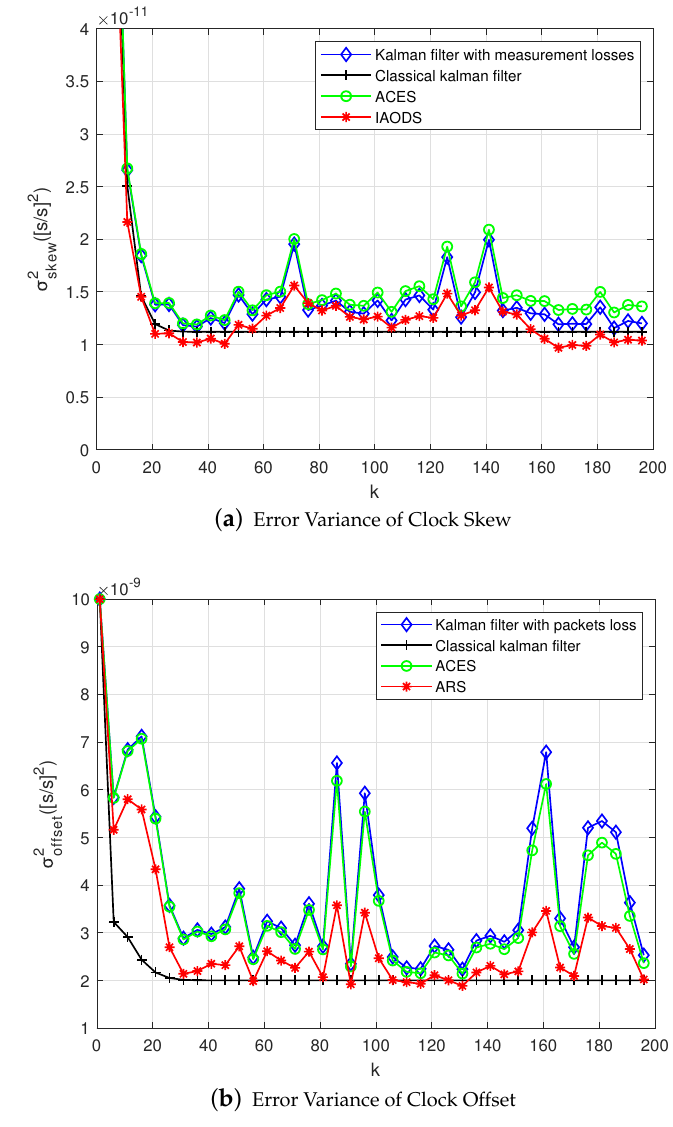
Figure 4. Error Variance of the First-order Kalman Filter in Single-hop